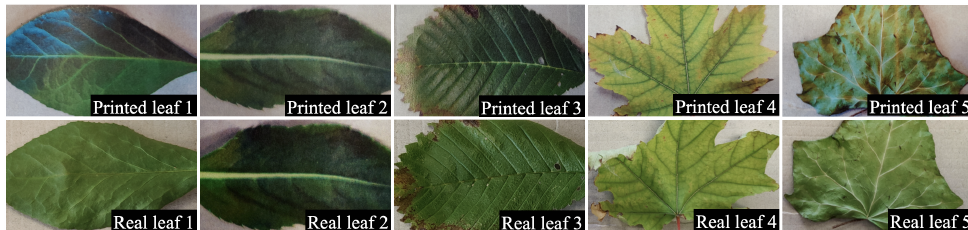
Figure 9. Comparison of printed and real leaf by RGB camera. Part of the comparison between printed and real leaf pairs was taken from an RGB camera.